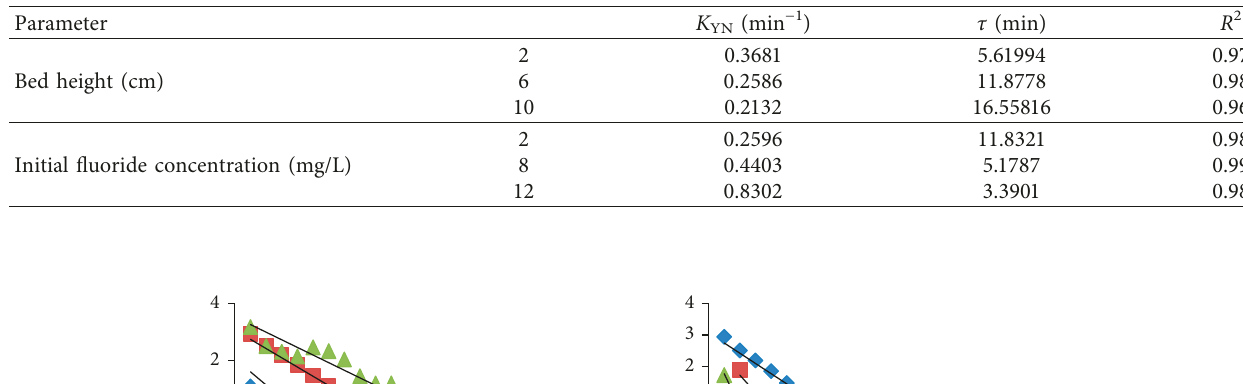
Figure 9: Yoon–Nelson model at different (a) bed heights and (b) initial concentrations by QPKS. Table 6: Yoon–Nelson constant values at different bed heights and initial concentrations.